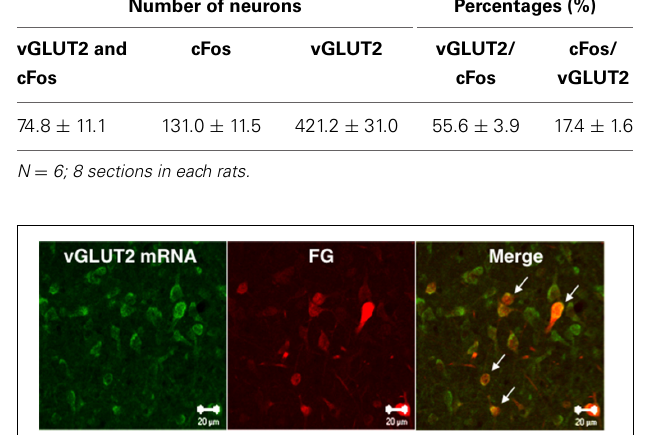
FIGURE 4 | Confocal microscope images showing vGLUT2 mRNA-positive (green) and FG-ir (red) neurons in the caudal part of lateral PAG. Arrows indicate vGLUT2 mRNA-positive and FG-ir double-stained neurons. Scale bars: 20 μ